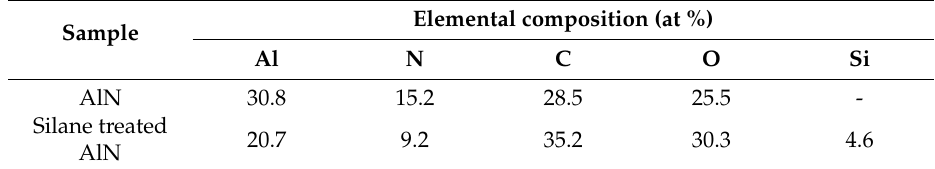
Table 2. Relative percentages of elemental composition of the AlN and silane treated AlN.